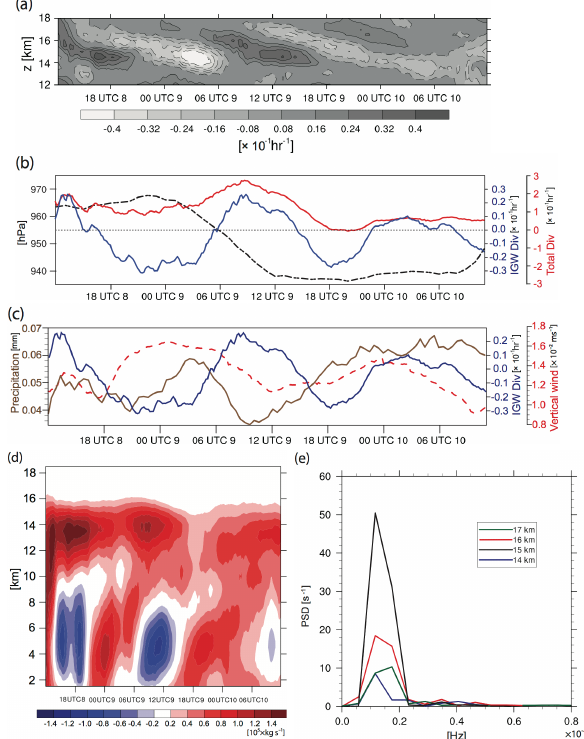
Fig. 1. (a) Time–height cross section of the domain-averaged HDTGW from 12 to 18kma.g.l. Dashed and solid lines denote neg- ative (convergence) and positive (divergence) values, respectively. (b) Time series of total divergence at 16kma.g.l. (red), HDTGW (blue) and minimum sea-level pressure (dot dashed). (c) Time se- ries of HDTGW at 16kma.g.l. (blue), domain-averaged vertical ve- locity averaged over 3 to 15kma.g.l. (red dashed), and domain- averaged 30min accumulated precipitation amount (brown). (d) Time–height cross section of the vertical mass transport. (e) The power spectral density (PSD) of the HDTGW with respect to fre- quency at selected heights from 14 to